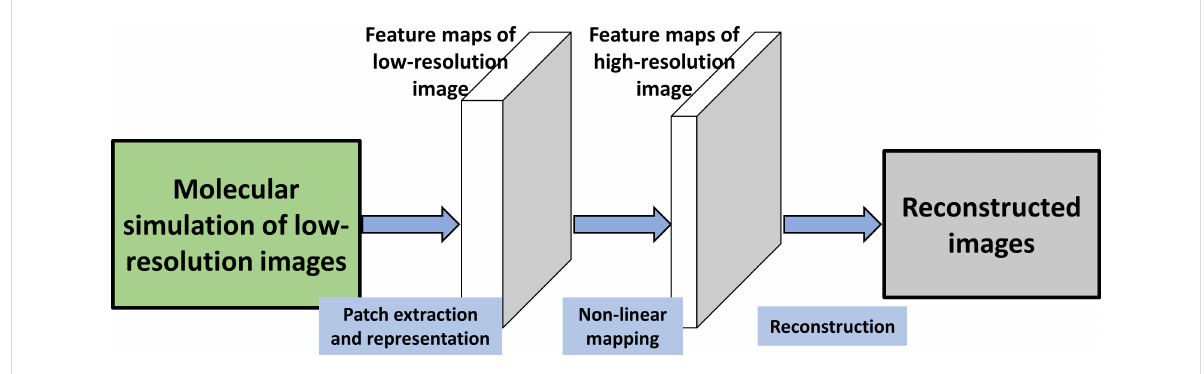
Figure 4: The flow chart of the proposed SRCNN reconstruction method. First, the low-resolution simulated image is obtained, then the SRCNN method is used to reconstruct the high-resolution image. The SRCNN consists of three layers to implement feature extraction, non-linear mapping, and reconstruction,